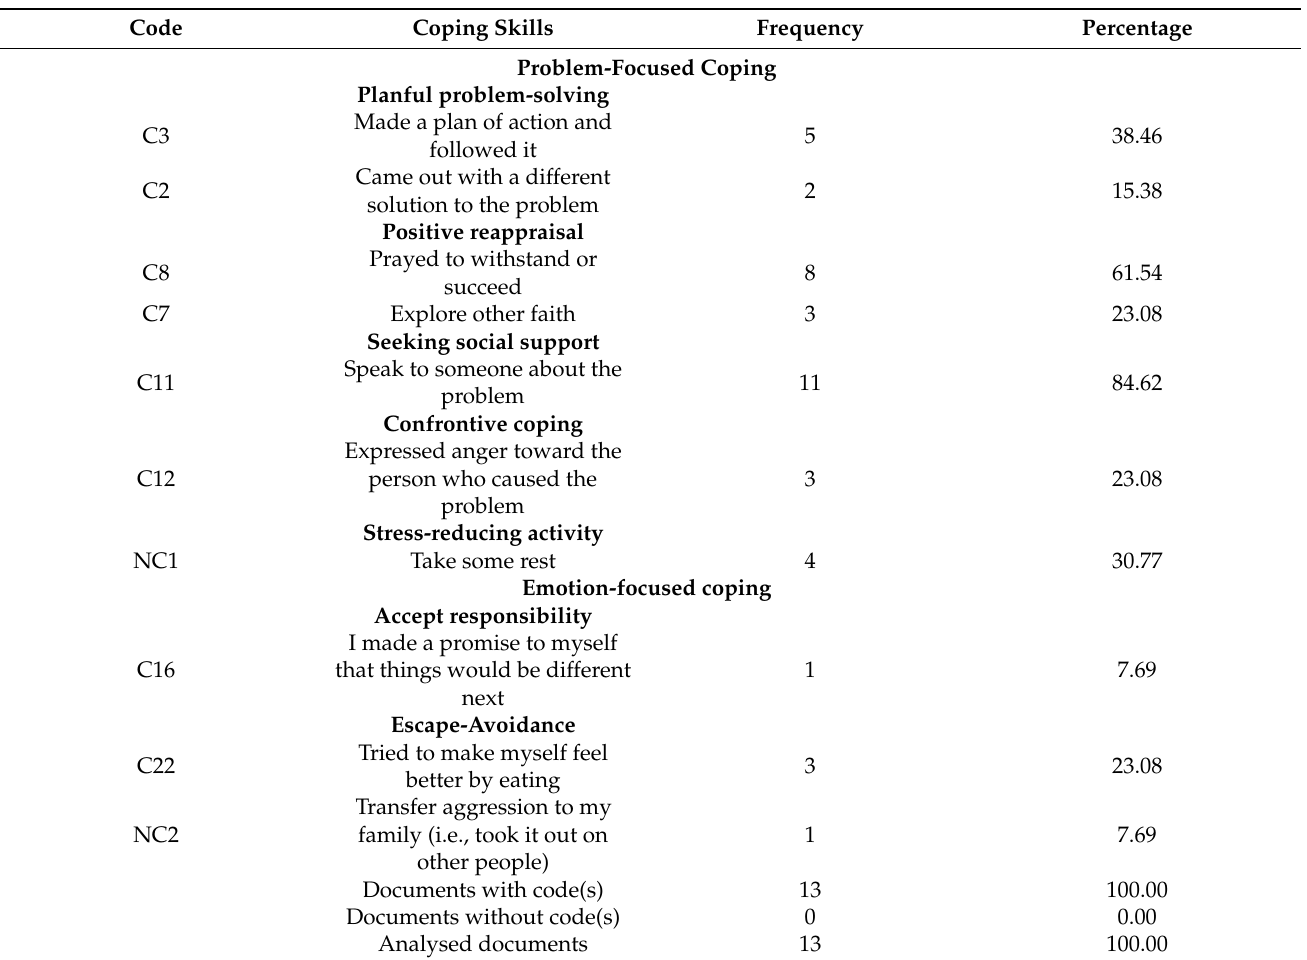
Table 5. Coping skills deduced based on Thematic